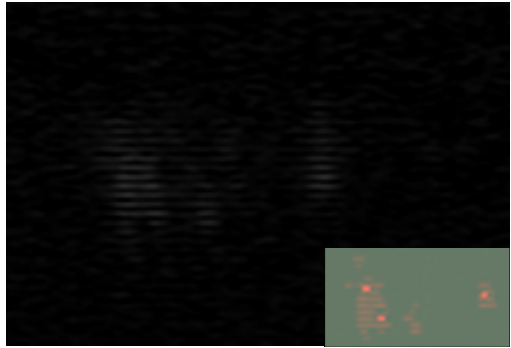
Figure 2. Sprite static image.